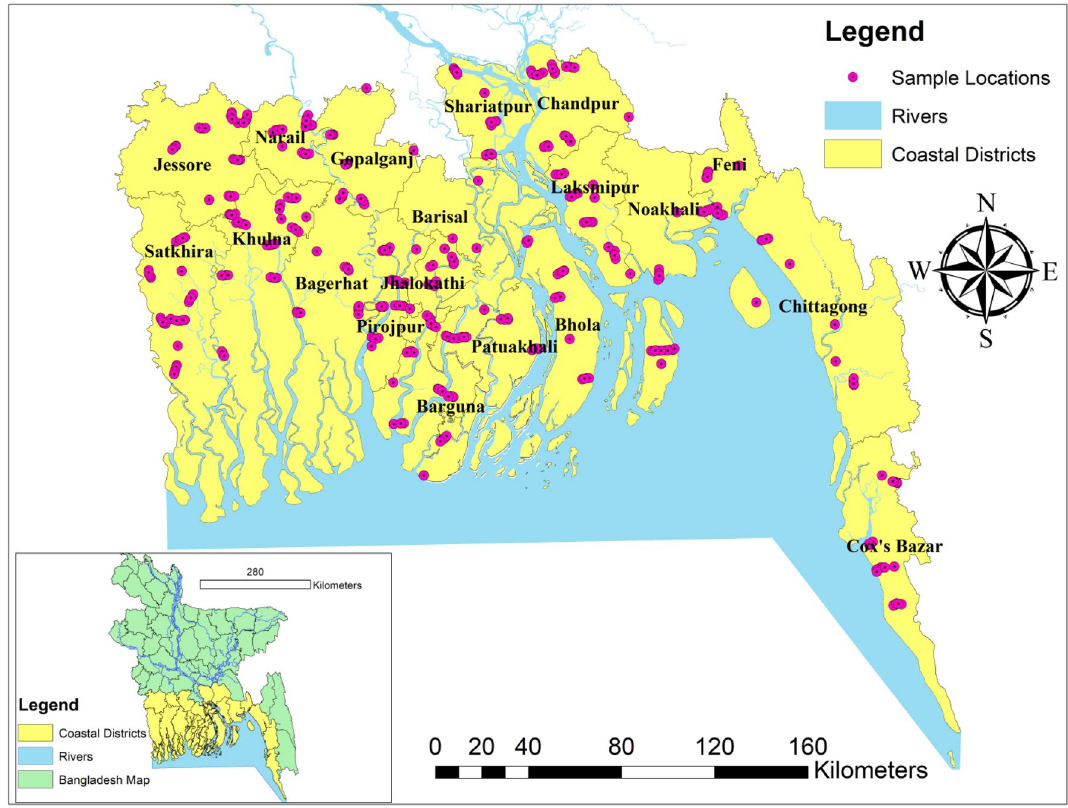
Figure 1. Location of sampling point in area study during the wet season; map of coastal regions of Bangladesh.